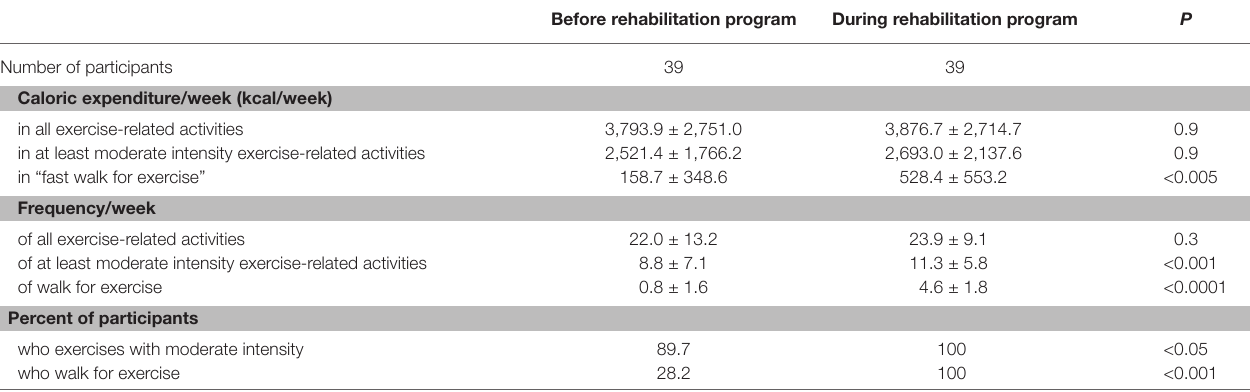
Before rehabilitation program During rehabilitation